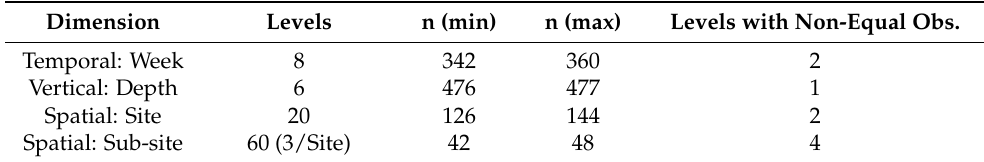
Table 1. Dimensions of the in situ data. Levels = number of unique observations, n = total number of repeated observations on each dimension.